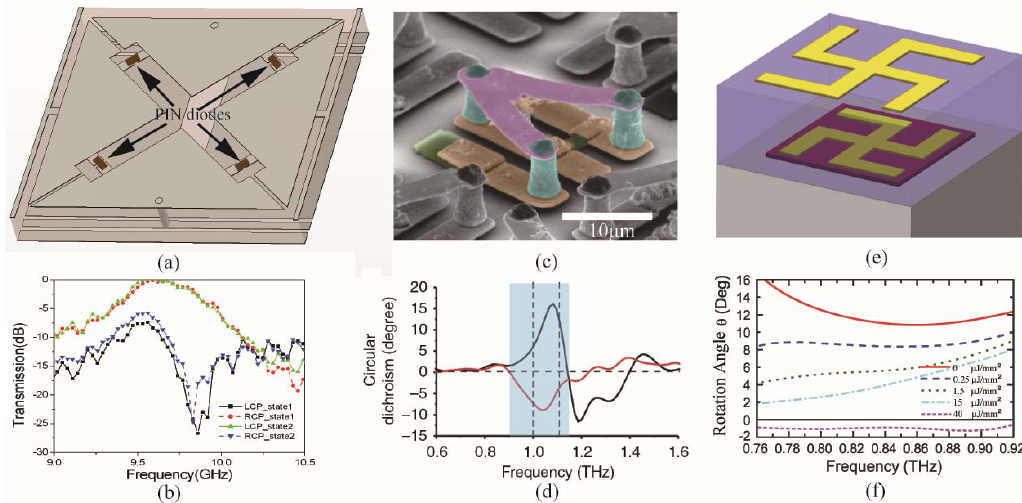
Figure 6. Reconfigurable chiral metamaterial. ( a ) Scheme of the unit cell of chiral metamaterial with four PIN diodes loaded; ( b ) The circular transmission spectra of the chiral metamaterial in ( a ) with different working states of the diodes; ( c ) Three-dimensional reconfigurable chiral metamaterial with silicon pad (green part); ( d ) Circular dichroism of the chiral metamaterial in ( c ) when it is illuminated by light or not; ( e ) Reconfigurable gammadion shape chiral metamaterial with semiconductor substrate (red part); ( f ) Rotation angle of the chiral metamaterial in ( e ) under different illumination intensities. ( a ) and ( b ) are reproduced with permission[105]. Copyright John Wiley and Sons, 2014; ( c ) and ( d ) are reproduced with permission [109]. Copyright Nature Publishing Group, 2012; ( e ) and ( f ) are reproduced with permission [110]. Copyright American Physical Society, 2012.